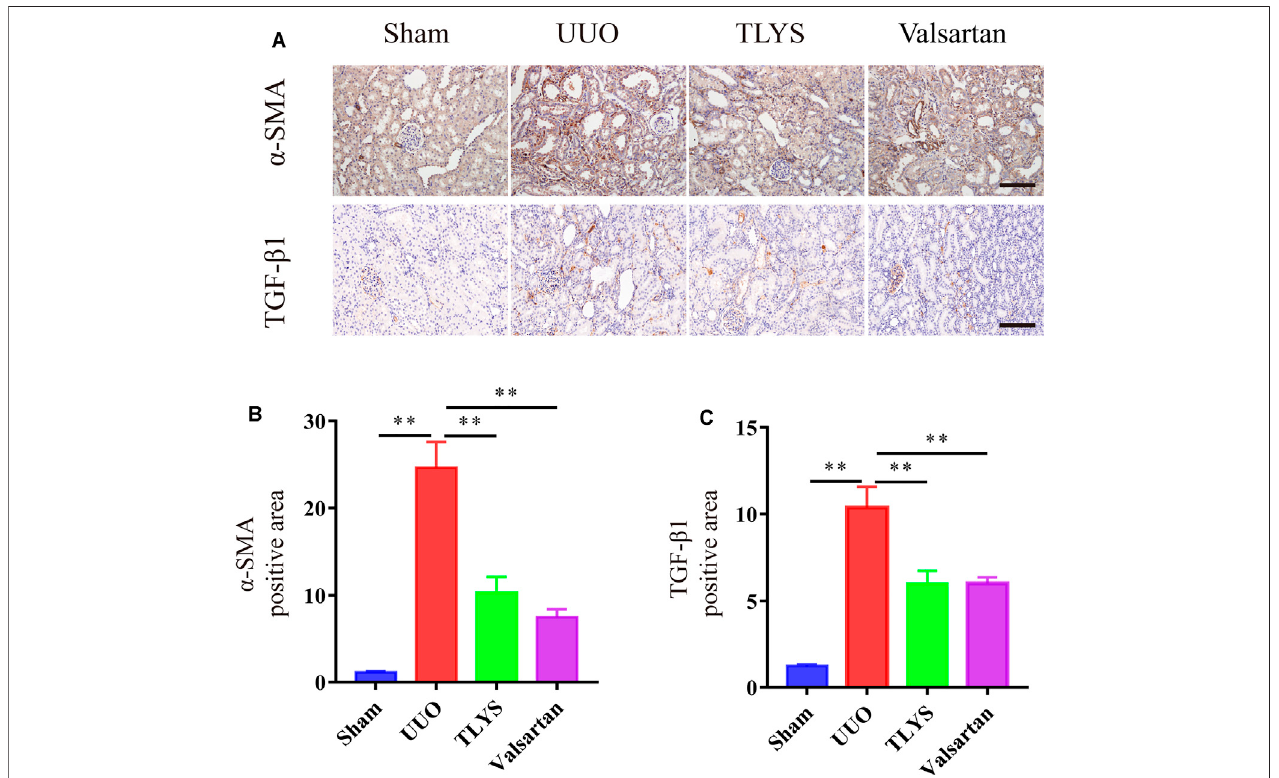
FIGURE3| TLYSdecoctionsuppressesa-SMAexpressionandTGF- β 1expressioninUUOrats. (A – D) Expressionlevelsofa-SMAandTGF- β 1inthekidneywere detected by immunohistochemistry and analyzed the optical intensity of the abovementioned proteins was measured ( n (cid:2) 6). The magni fi cation of the images is × 200, scale bar (cid:2) 50 μ m. Data were presented as means ± SEM ( n (cid:2) 6). * p < 0.05, ** p < 0.01.